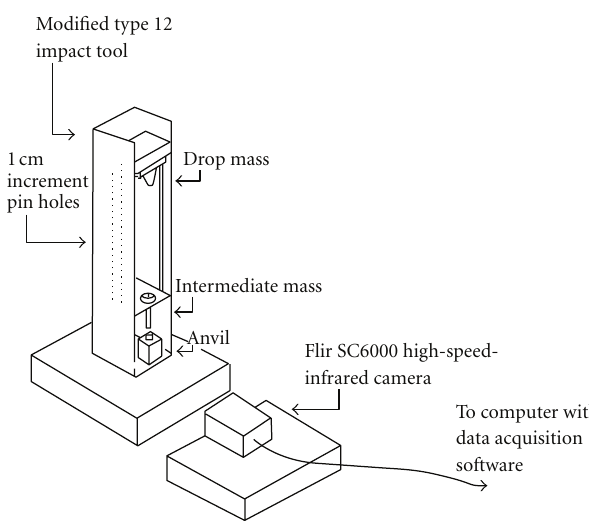
Figure 4: Modified type 12 impact tester [8].